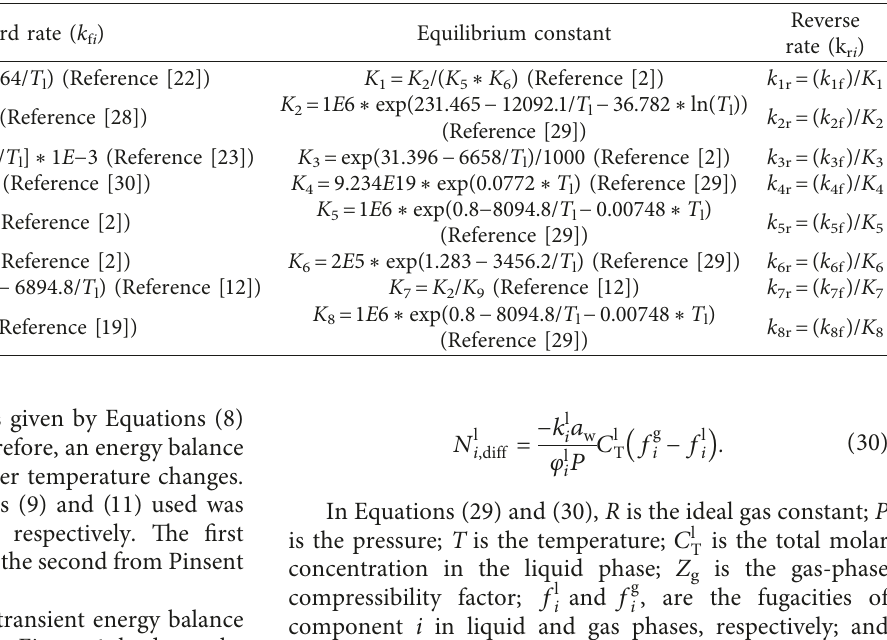
Table 3: Information used in solving the proposed reaction